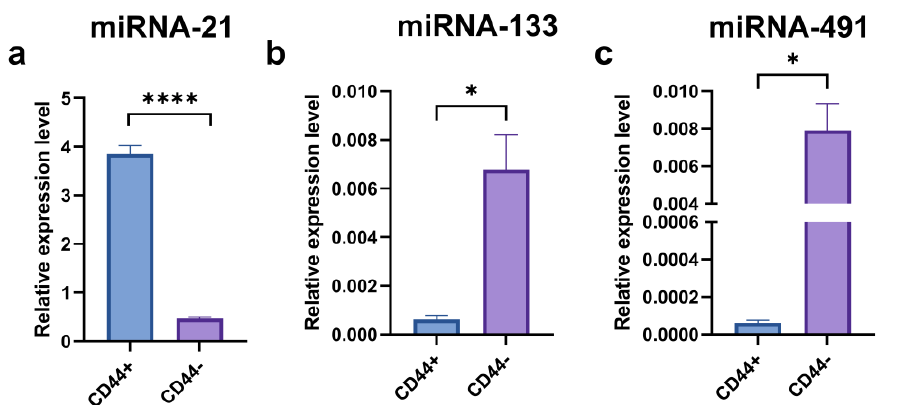
Figure 13. qPCR analysis of relative miRNA-21 ( a ), miRNA-133 ( b ), and miRNA-491 ( c ) expressions in CD44-positive versus CD44-negative cells; * p ≤ 0.05, **** p ≤ 0 .0001.